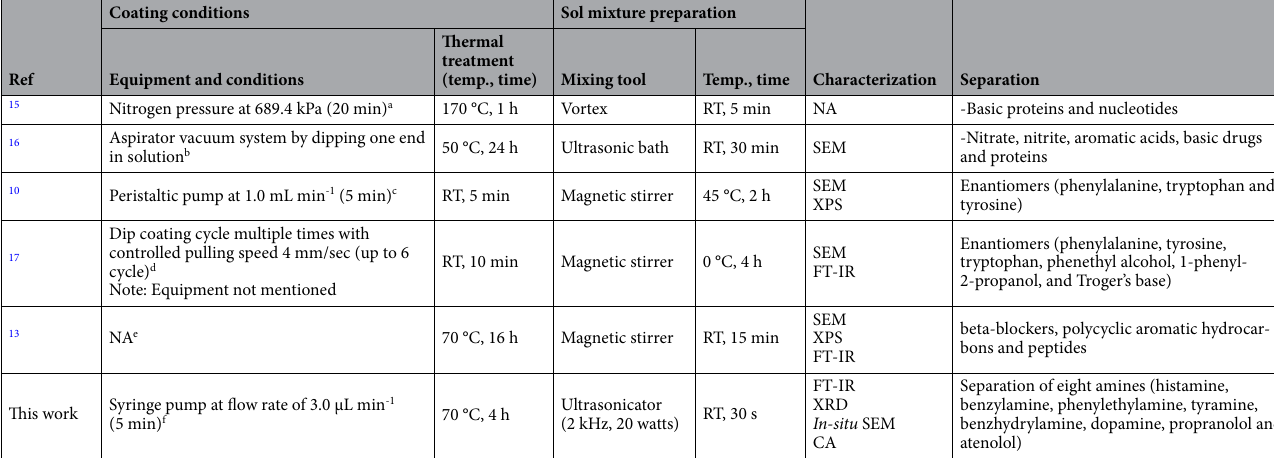
Table 1. Previous reports of the various sol–gel mixtures and conditions for gel formation, together with the characterization of the coating and application of the coated capillary. RT Room temperature, NA Not available, SEM Scanning electron microscope, XPS X-ray photoelectron spectroscopy, FT-IR Fourier- transform infrared spectroscopy, XRD Powder X-ray diffraction, CA Contact angle measurement. a